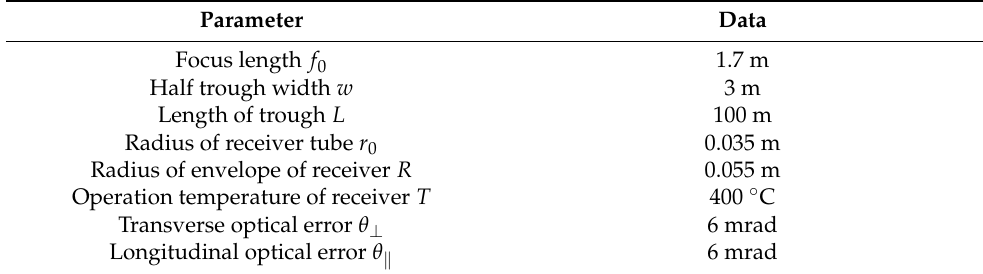
Table 1. Parameter of the typical parabolic trough solar